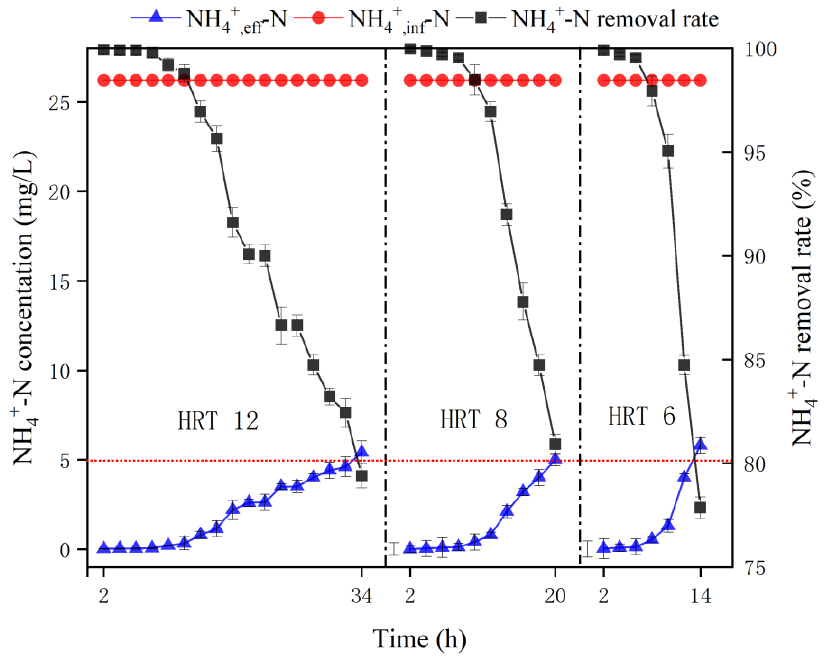
Figure 2. Breakthrough curve of MBBR with different HRT. Vertical bars represent ± SD of the means ( n = 3). Table 2. Adsorption parameters of MBBR with different